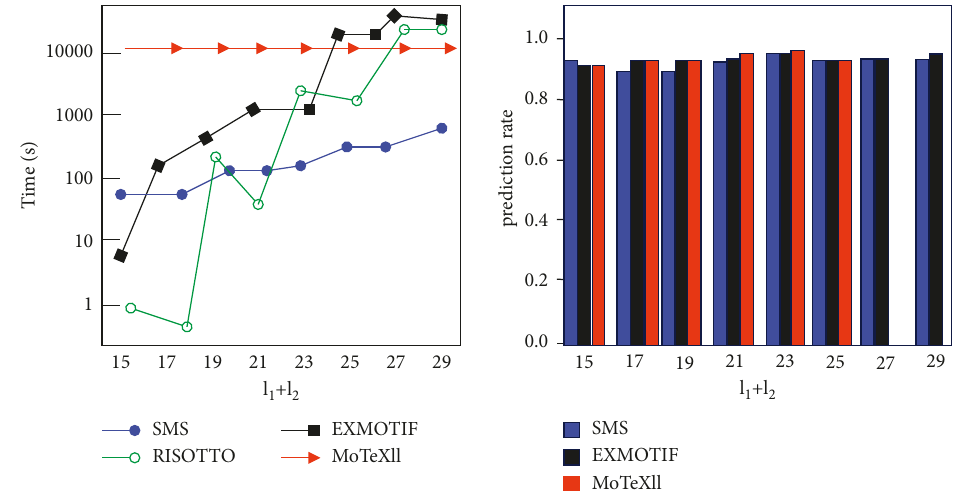
Figure 4: Experimental results at different l